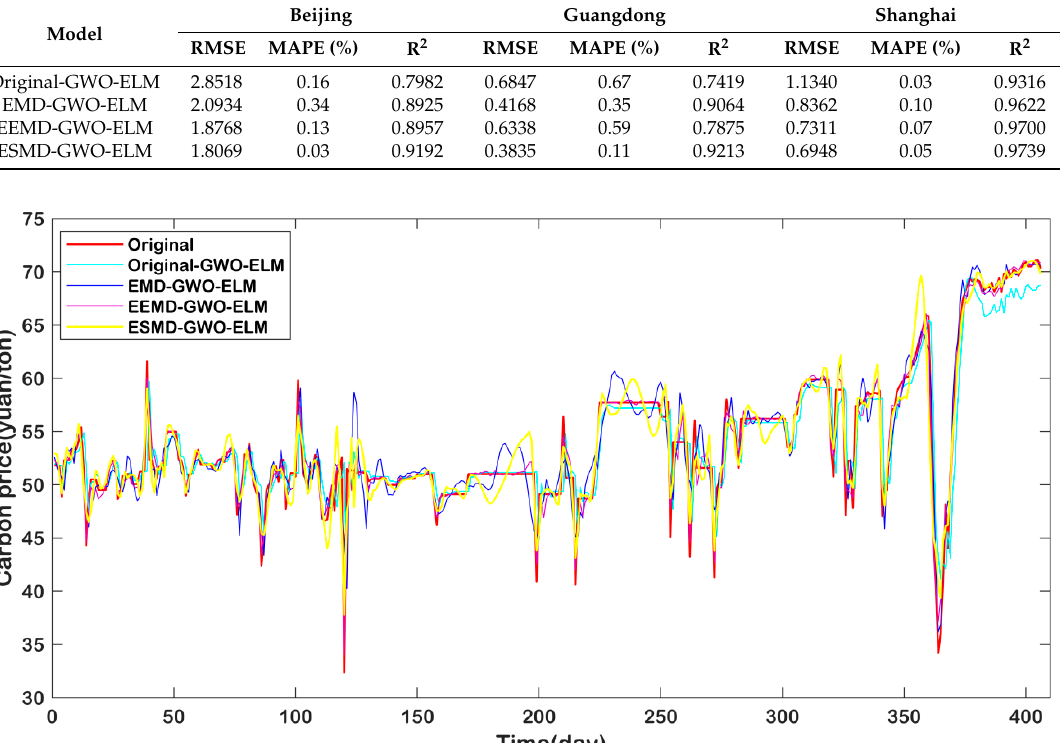
Table 8. Analysis of the Beijing, Guangdong, and Shanghai forecasting results. Model